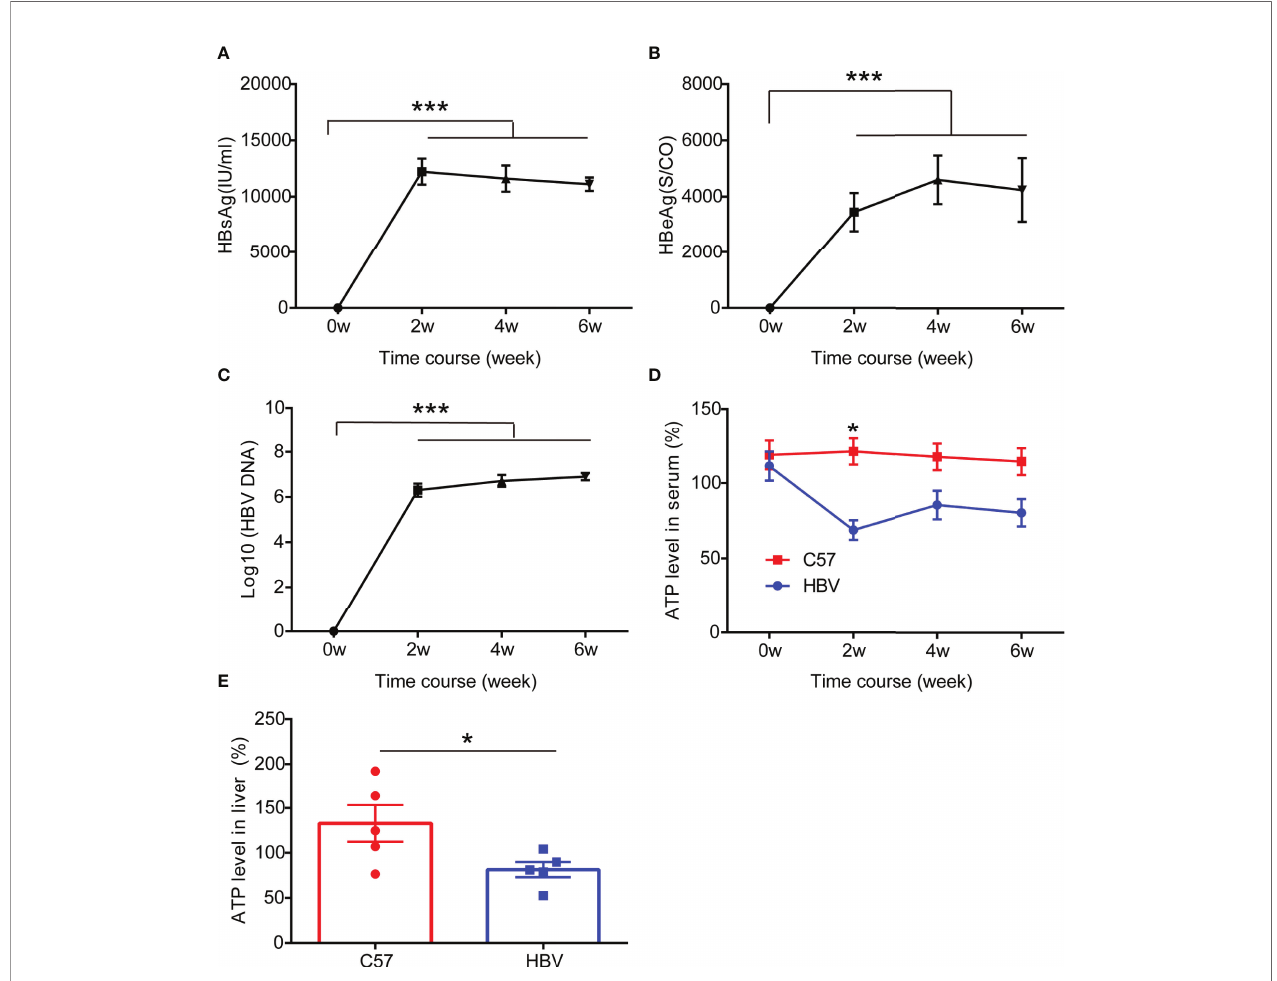
FIGURE 3 | HBV elicits ATP decline in HBV-infected mice. (A – C) The representation of HBV markers in HBV-infected C57BL/6 mice including HBsAg, HBeAg, and HBV DNA (n=5). (D) The level of ATP in serum from HBV-infected C57BL/6 mice and age and gender matched non-HBV-infected C57BL/6 mice (n=5). (E) The level of ATP in the liver from HBV-infected C57BL/6 mice and age and gender matched non-HBV-infected C57BL/6 mice (n=5). Data are presented as means ± SEM, * p < 0.05, ***p < 0.0001; one-way ANOVA post-hoc Student – Newman – Keuls